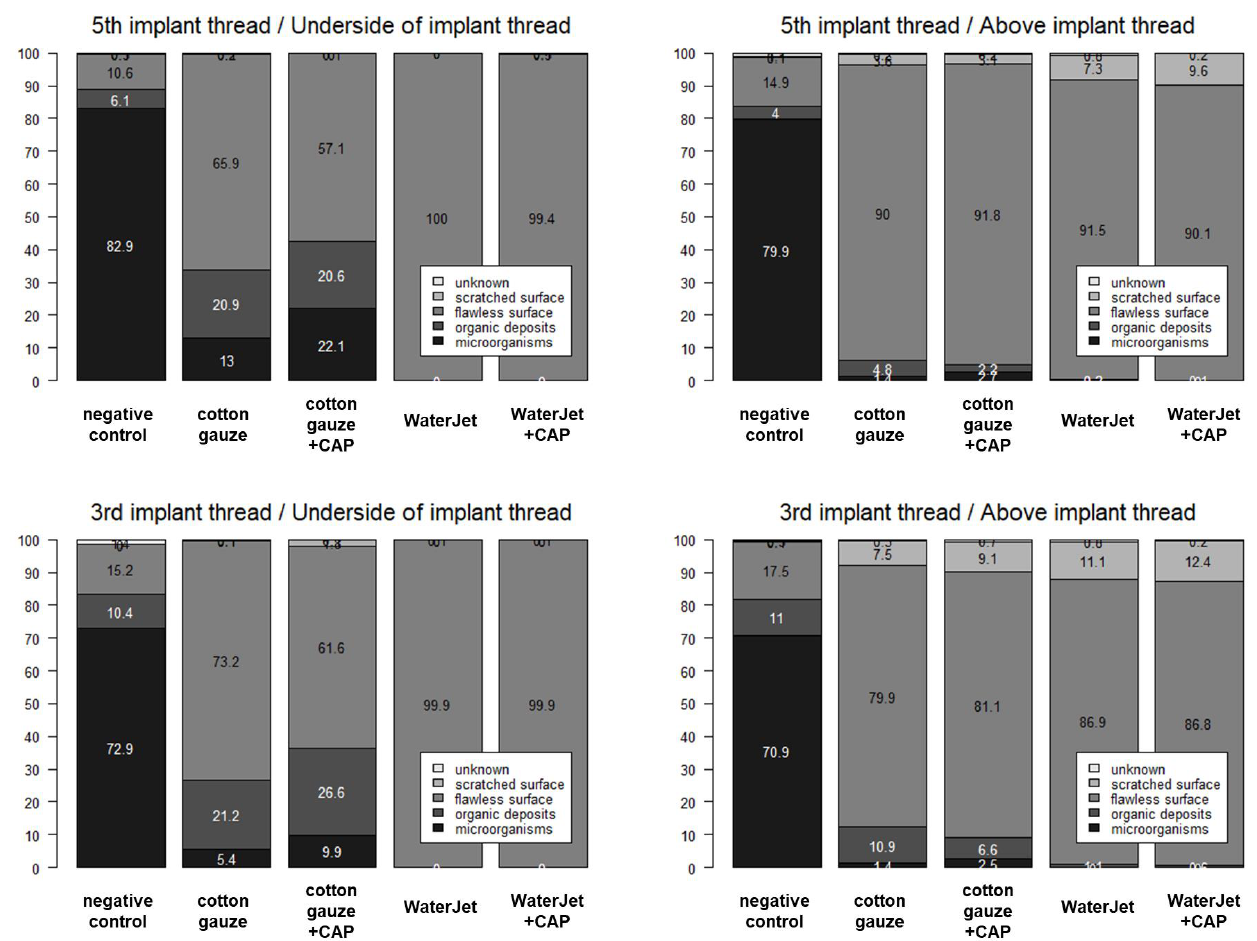
Figure A1. Numbers in mean percentages of microorganisms, organic deposits, flawless surface, scratched surface, and unknown by location (3rd vs. 5th implant thread; underside versus above implant thread) and treatment. CAP, cold atmospheric pressure plasma. Data are presented as median (25% percentile; 75% percentile) and [min – max]. Numbers with difficult readability at the edges of the graphes are mostly between 0 – 3 and therefore of minor relevance to the overall antimicrobial effect in the respective category indicated in the legends.